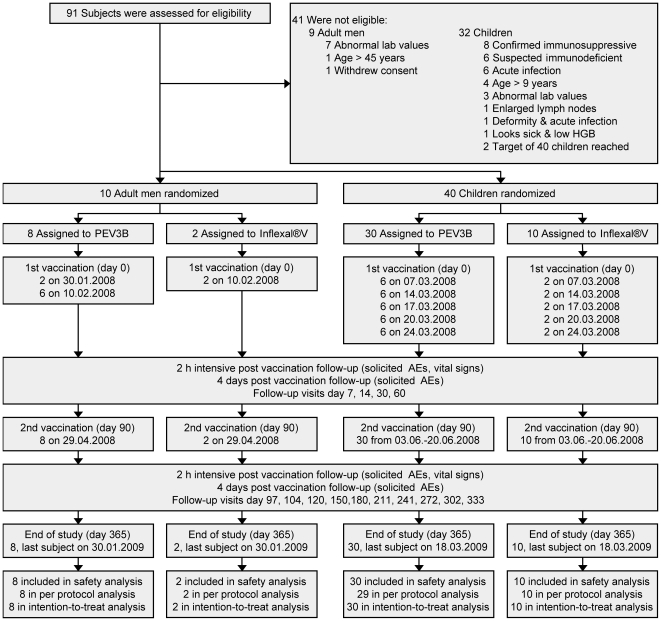
Study flow chart.